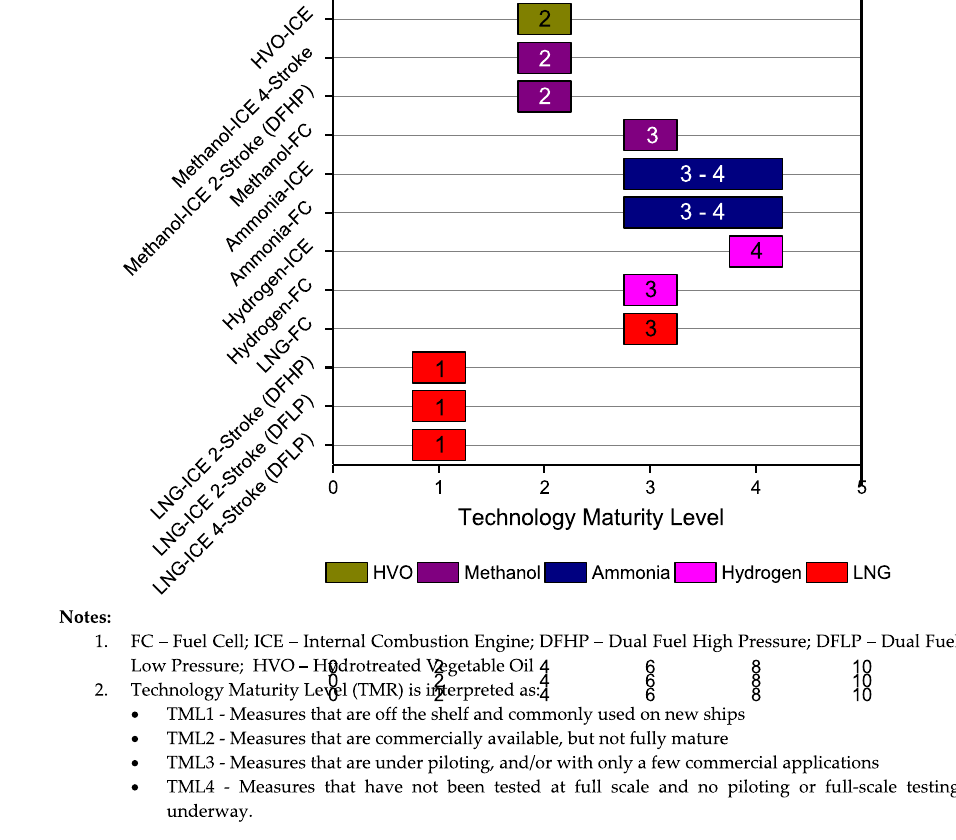
Fig. 22 Technology maturity level for various alternative fuels, data derived from [152]. FC Fuel Cell; ICE Internal Combustion Engine; DFHP Dual Fuel High Pressure; DFLP Dual Fuel Low Pressure; HVO Hydrotreated Vegetable Oil.